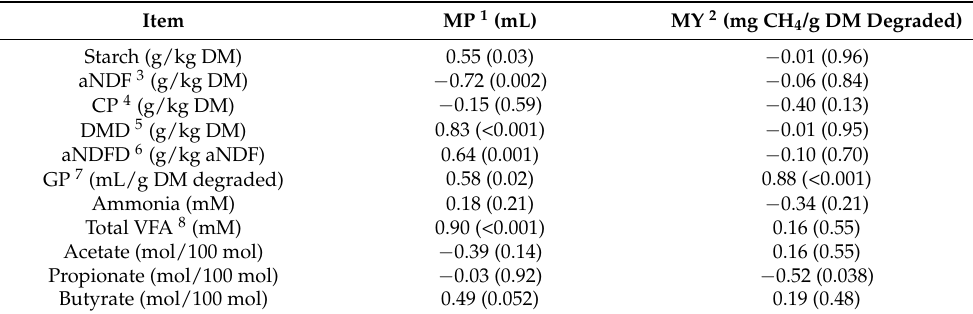
Table 4. Pearson c orrelation coefficient and significance ( p- values) in parentheses between methane emissions and chemical composition, degradation, and fermentation end-products examined over two locations and two varieties of each cereal crop (barley, oat, triticale, and wheat) grown and harvested in central